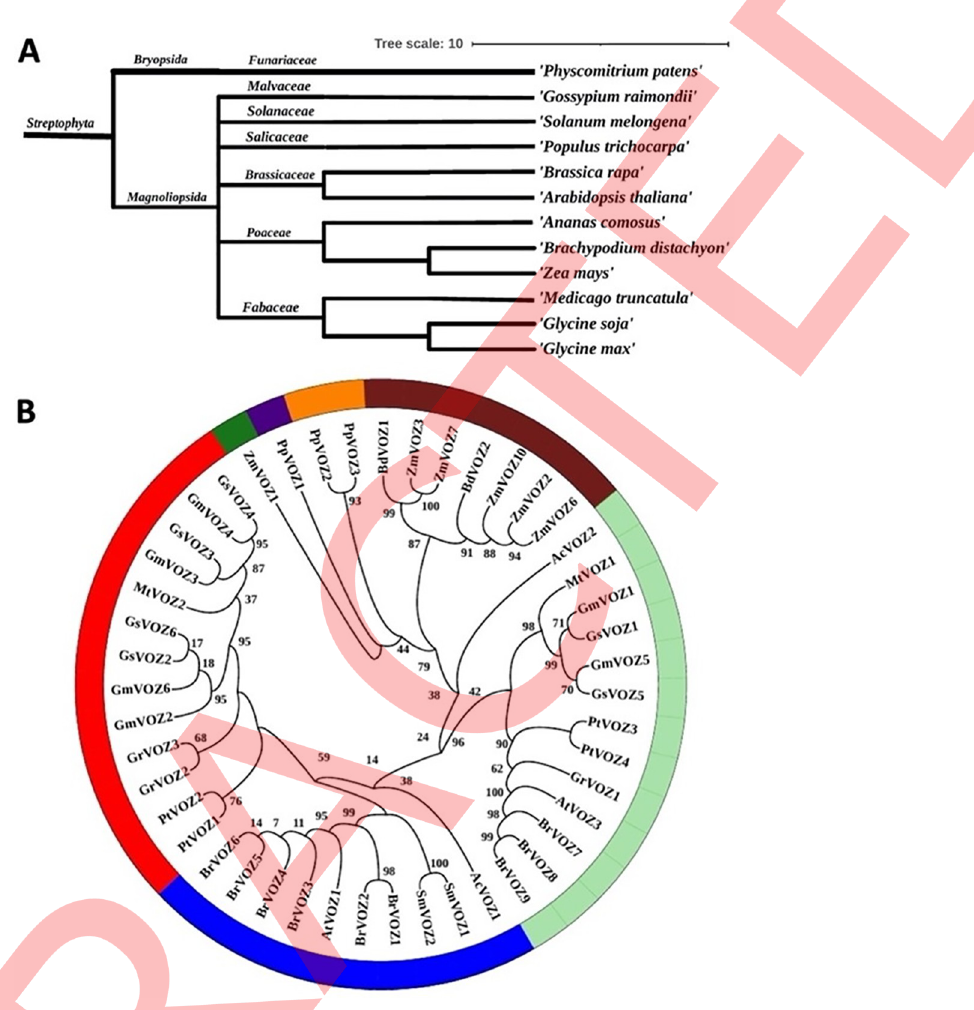
Fig 3. Phylogenetic analyses of vascular plant one-zinc-finger (VOZ) from 12 different species. (A) The phylostartum analyses of VOZ gene family. (B) Phlyogenetic tree divided all 47 genes into seven clades. Bootstrap values were also mentioned near the node of each